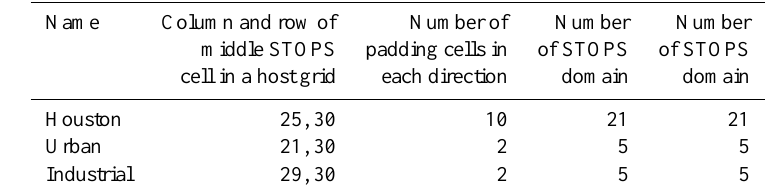
Table 1. Specifications of STOPS domains.